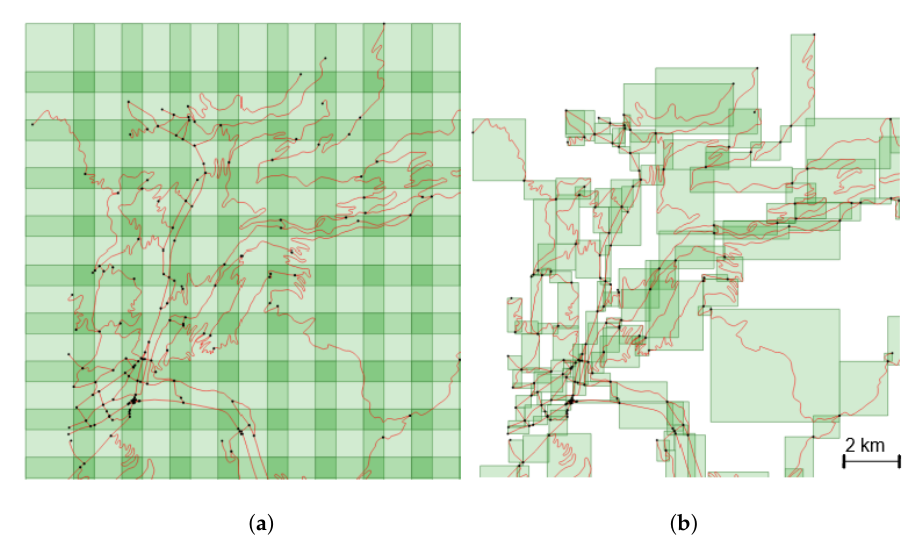
Figure 3. Two proposed tiling methods. ( a ) Fixed-size tiles. ( b ) Object-based